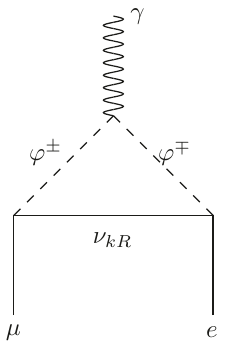
Figure 2 . Feynman diagram corresponding to the dominant contribution to the µ → eγ